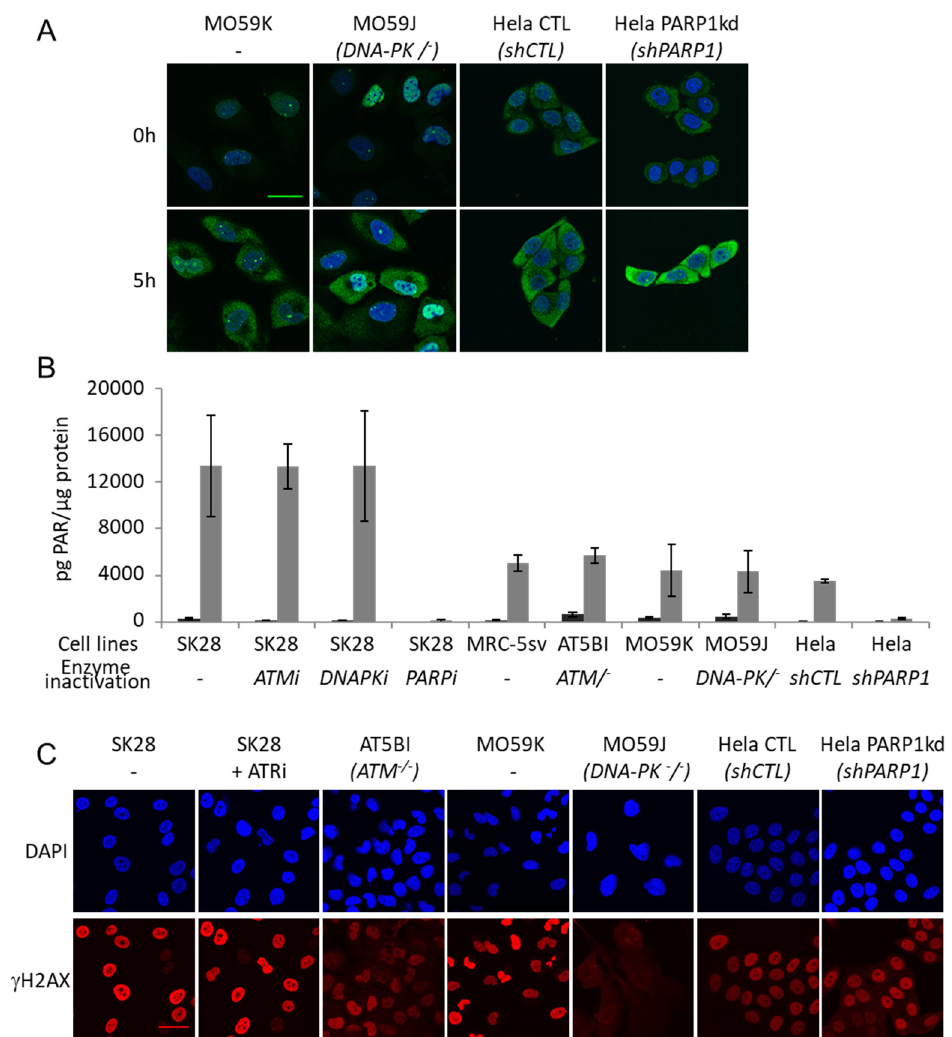
Figure 2. Main DNA damage-signaling enzymes are activated by AsiDNA independently of each other. ( A ) P-ATM (green) immunostaining after 5 h of AsiDNA treatment or no treatment in DNA-PK and PARP1-deficient cells; DAPI staining (blue). Scale bar: 30 µm ( B ) Quantification of PARylation by ELISA after 24 h of AsiDNA treatment (gray) or no treatment (black) in SK28 treated with ATM inhibitor (KU55933), DNA-PK inhibitor (NU7026), PARP inhibitor (olaparib) or in ATM, DNA-PK or PARP1 deficient cell lines. ( C ) Immunostaining of 𝛾 H2AX after 24 h of AsiDNA treatment in SK28 inhibited for ATR with ceralasertib, in ATM and DNA-PK-deficient cell lines, or in PARP1 silenced cell line. Scale bar: 30 µm.